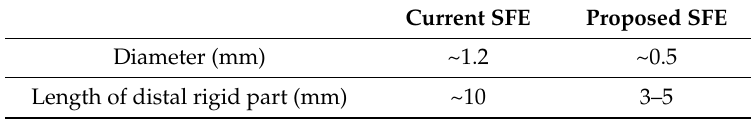
Table 2. Device dimensions of the proposed device compared to existing